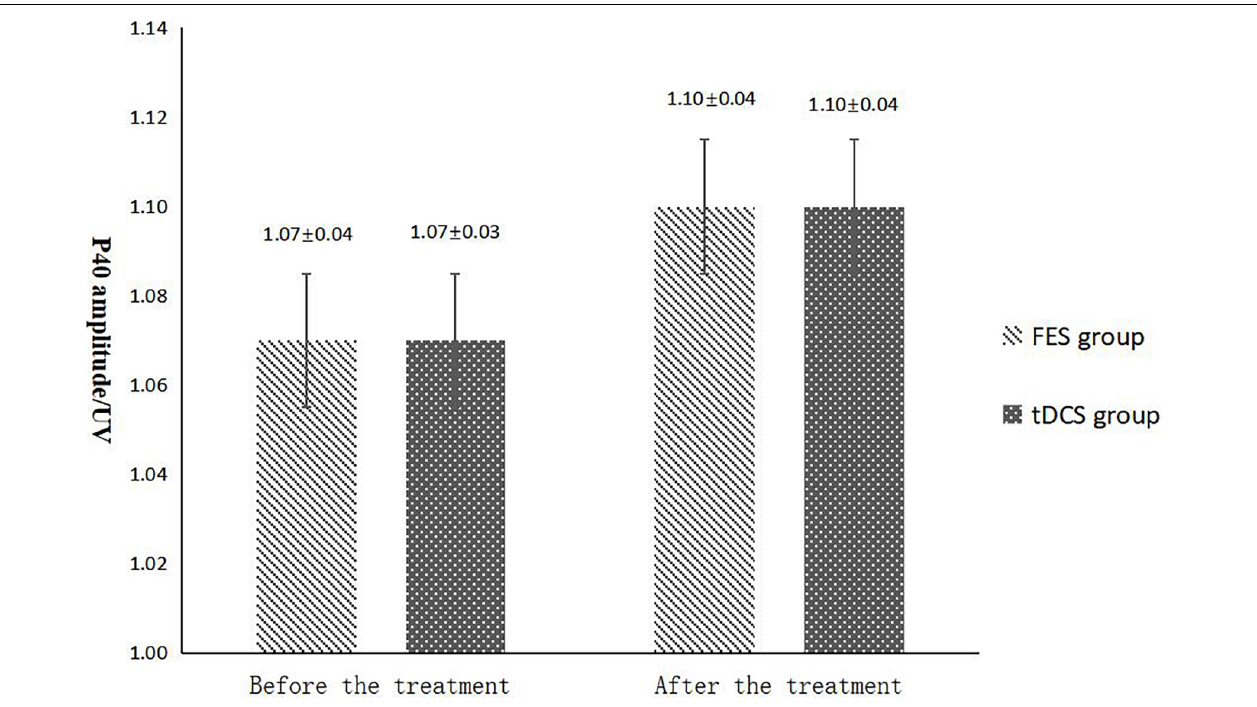
FIGURE 5 | P40 amplitude comparing improvement before and after FES and tDCS treatments in post-convalescent stroke patients. ∗ Indicates that the mean value of the tDCS and FES groups is significantly different at the same time point, p < 0.05. # Indicates that the mean score after treatment is significantly different from that before treatment, p <